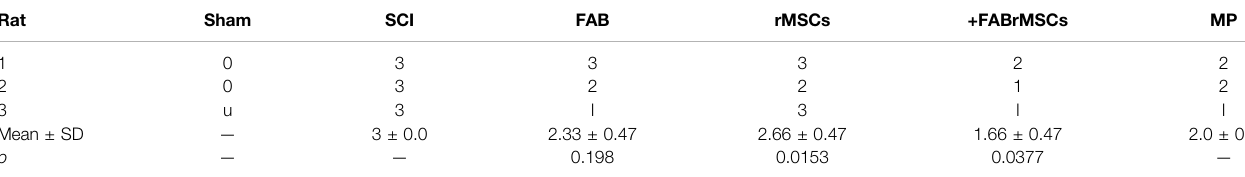
TABLE 5 | Histopathological evaluation by semi-quantitative Ustun classi fi cation system.